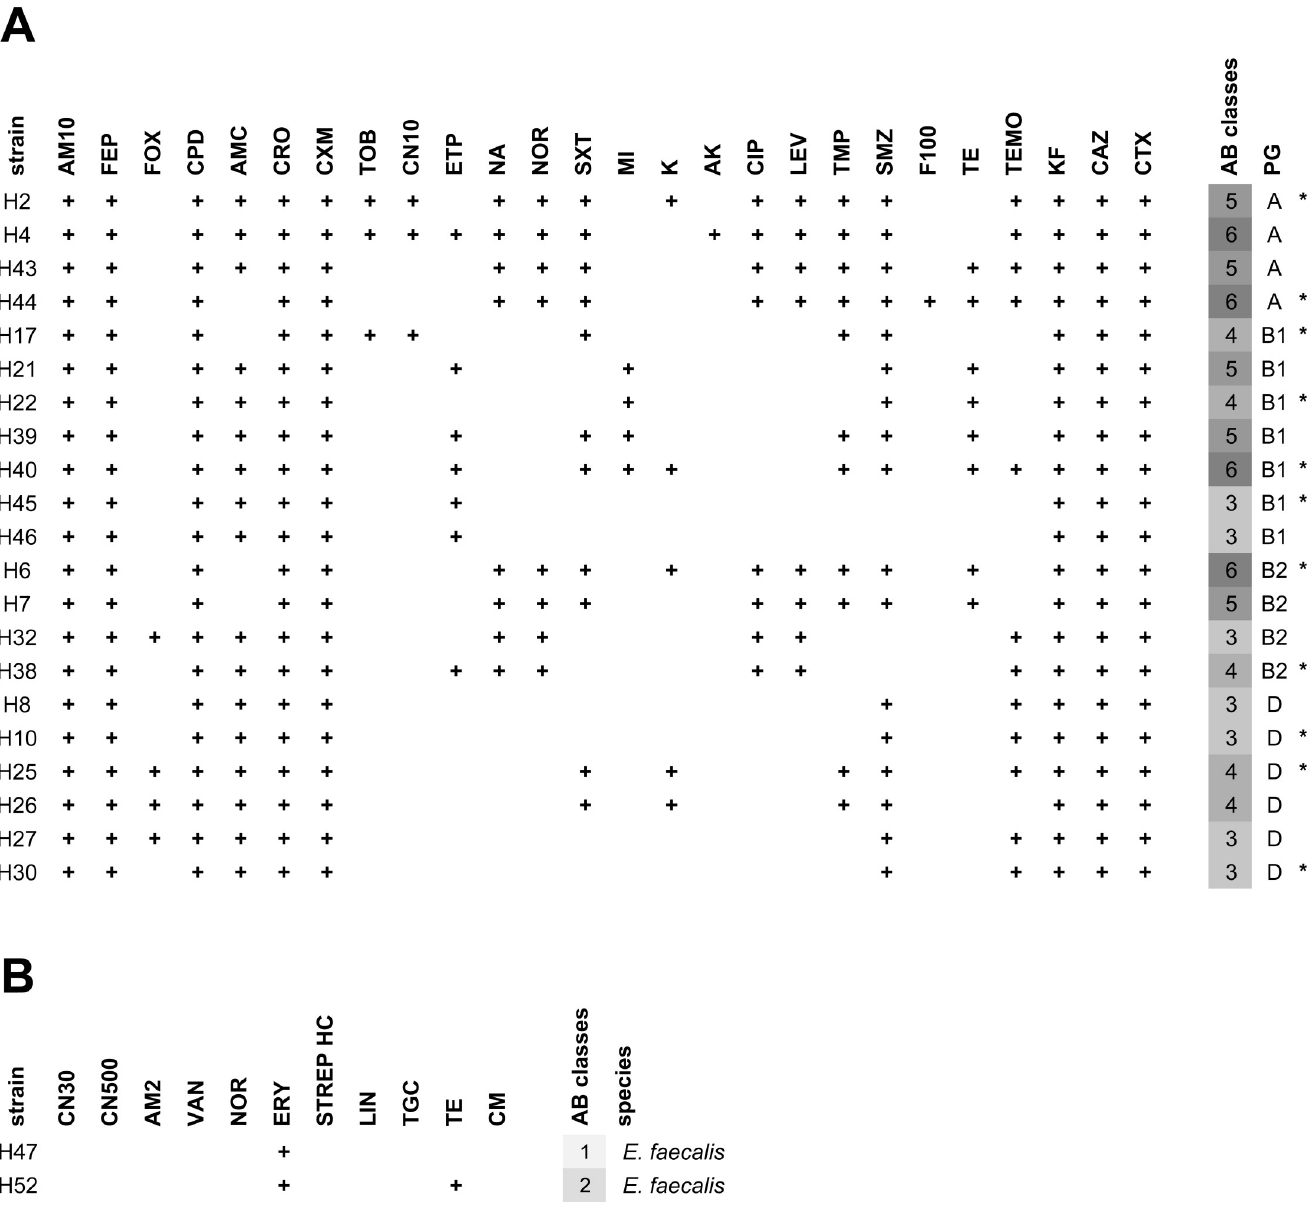
Fig 3. Antibiograms of ESBL-producing E . coli and presumptive VRE E . faecalis from irrigation water. E . coli and E . faecalis were tested against 32 or 11 clinically relevant antibiotics, respectively. Isolates were grouped by phylogenetic group. (A) Resistance profiles of ESBL-producing E . coli . AM10: ampicillin 10 μ g; FEP: cefepime; FOX: cefoxitin; CPD: cefpodoxime; AMC: amoxicillin-clavulanic acid; CRO: ceftriaxone; CXM: cefuroxime; TOB: tobramycin; CN10: gentamicin 10 μ g; ETP: ertapenem; NA: nalidixic acid; NOR: norfloxacin; SXT: trimethoprim-sulfamethoxazole; MI: minocycline; K: kanamycin; AK: amikacin; CIP: